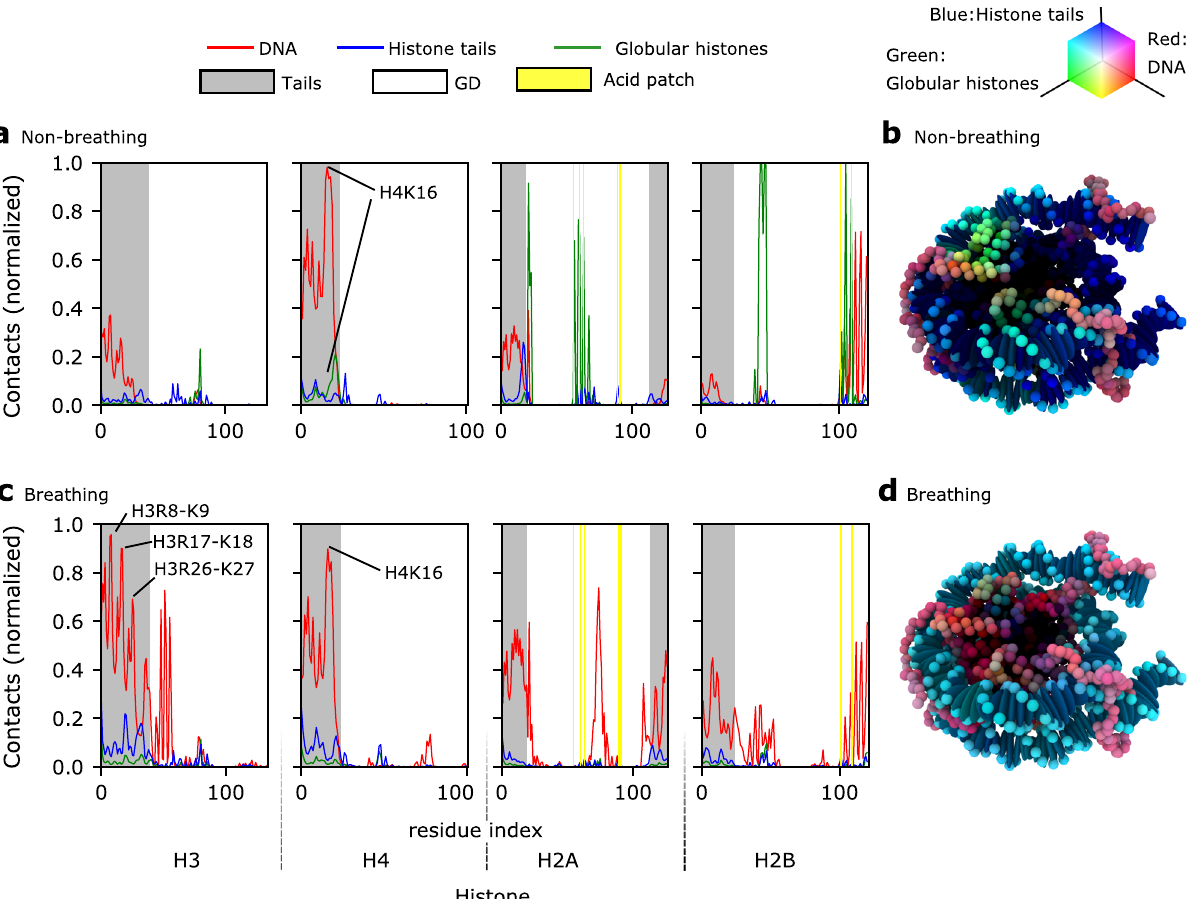
Fig. 4 Molecular interactions that sustain chromatin compaction. a Normalized fraction of nucleosome – nucleosome interactions (contacts) within compact chromatin for non-breathing nucleosomes that are mediated by histone – histone or DNA – histone interactions. The horizontal axes run across the histone protein residues within the core (i.e., H3, H4, H2A, and H2B, respectively) of a reference nucleosome, with the gray shaded areas highlighting histone tail residues, the white areas depicting globular domain residues, and the yellow vertical lines indicating the residues within the acidic patch for respective histones. The fraction of contacts is broken down by type: DNA – histone (red), histone tail – histone (blue), and globular domain – histone (green). b Visualization of the preferential types of interaction per residue or base pair in non-breathing nucleosomes. Each residue is represented by a sphere (centered on the C α ) and each DNA base pair by two spheres (centered on the phosphates) and one ellipsoid. The particles are colored according to the RGB value that is obtained by combining the red, green, and blue values of lines in a . c Same as in a but for breathing nucleosomes. d Same as in b but for breathing